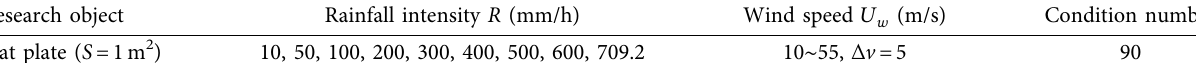
Figure 26: Distribution of particle diameters. Table 5: Calculation conditions.